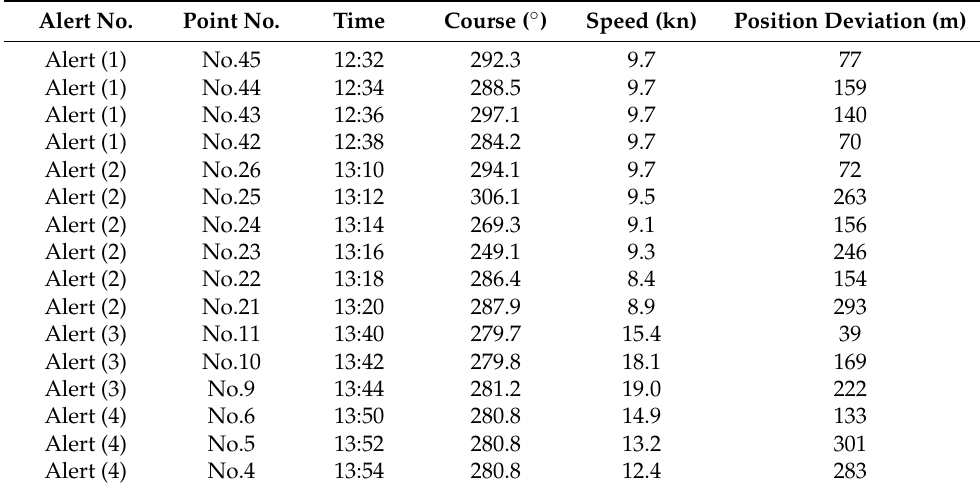
Table 11. Details detection results of trajectory abnormal based on